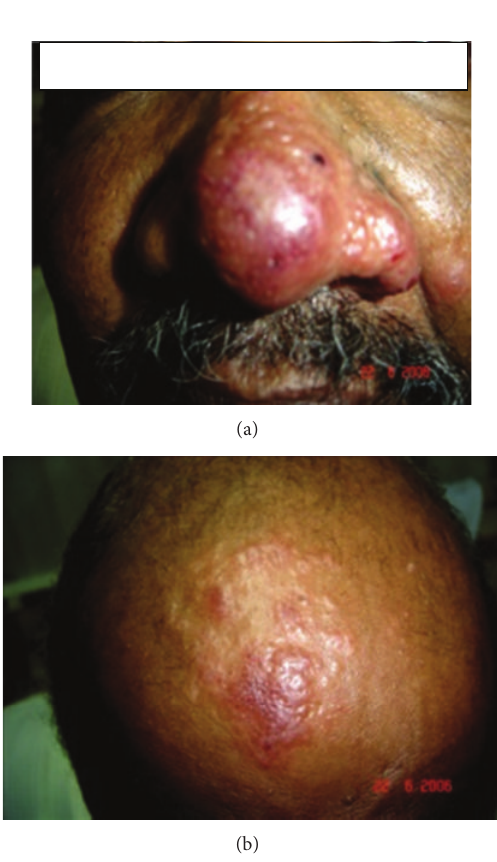
Figure 11: Of patient no. 3 showing lesions in the nose (a) and papules on scalp (b).